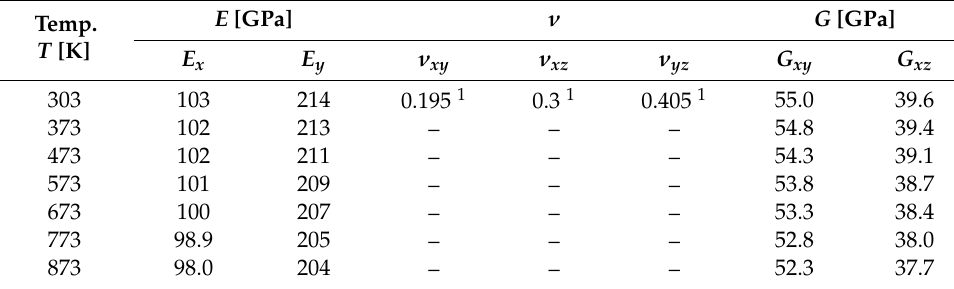
Table 5. Elastic properties ( E , ν , and G ) of mullite